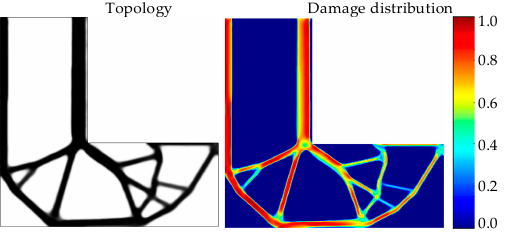
Figure 8. Optimal topology and damage distribution for an L-bracket subjected to multiple loads.